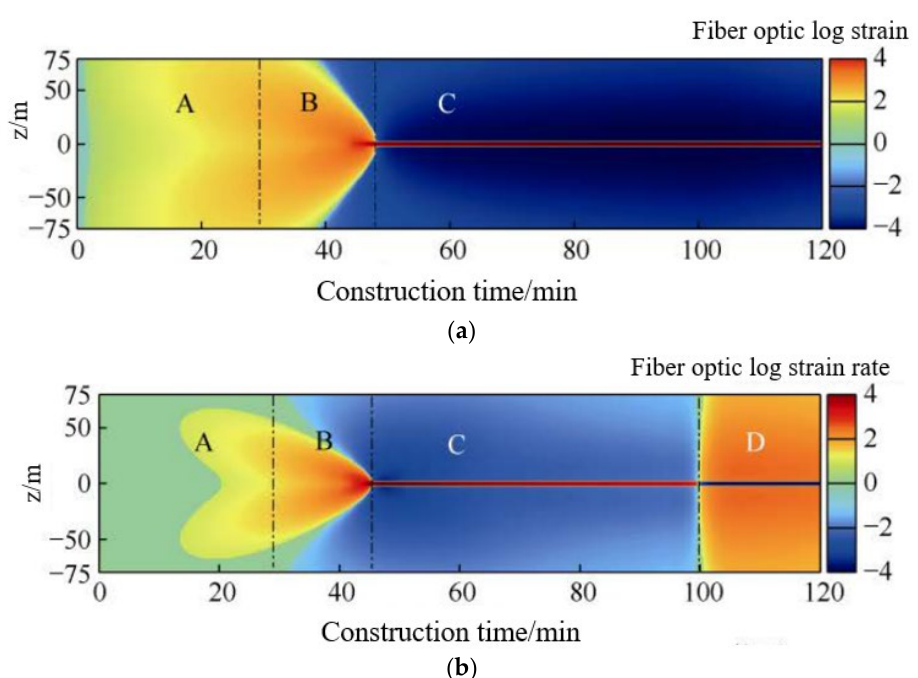
Figure 9. ( a ) Fiber strain-rate distribution with time [52]; ( b ) Fiber strain distribution with time [52].